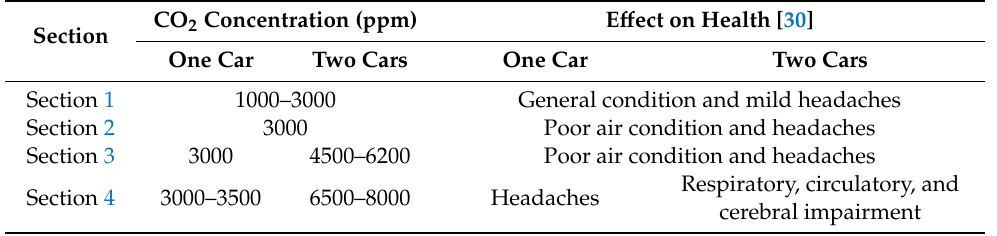
Table 6. Carbon-monoxide concentration at the major change periods, and influences on the body